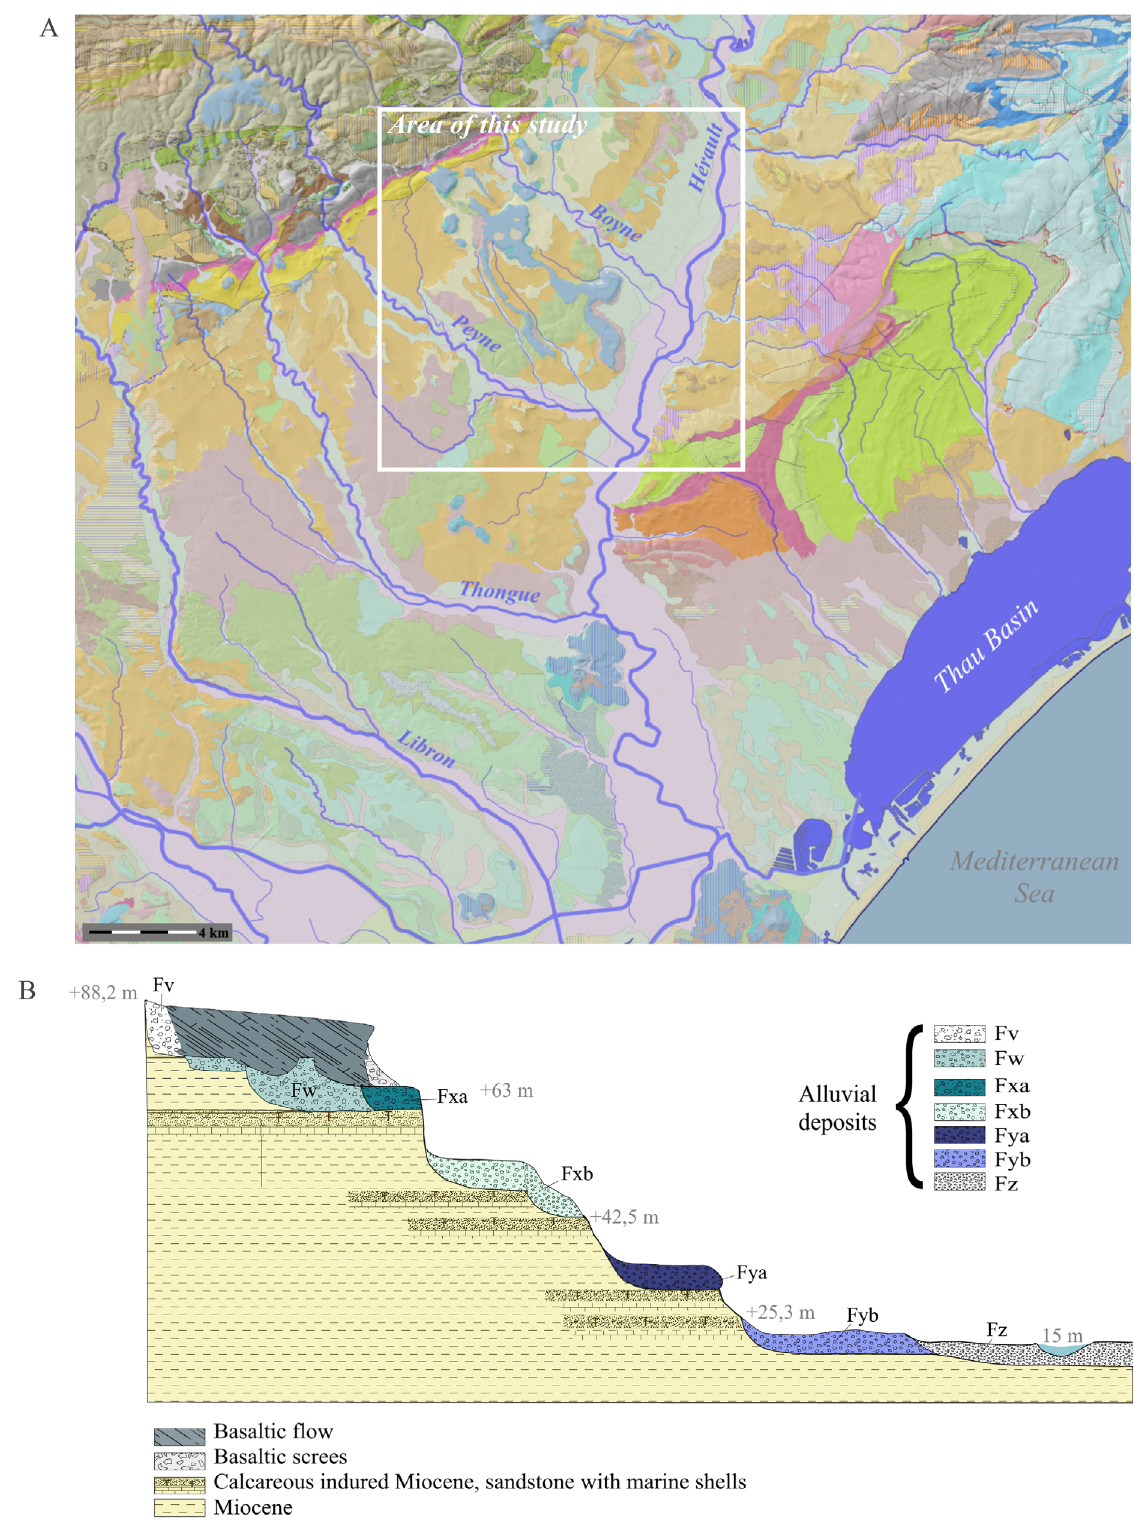
Figure 2. Synthetic view in section of the Hérault Valley terraces system. A: Location of the studied area on a geological map highlighting the hydrographic system (Vectorised 1:50 000 geological map, BRGM, caption available on infoterre.brgm.fr). B: Schematic cross-section of the Hérault Valley (after Ginouvez et al. 2016: see